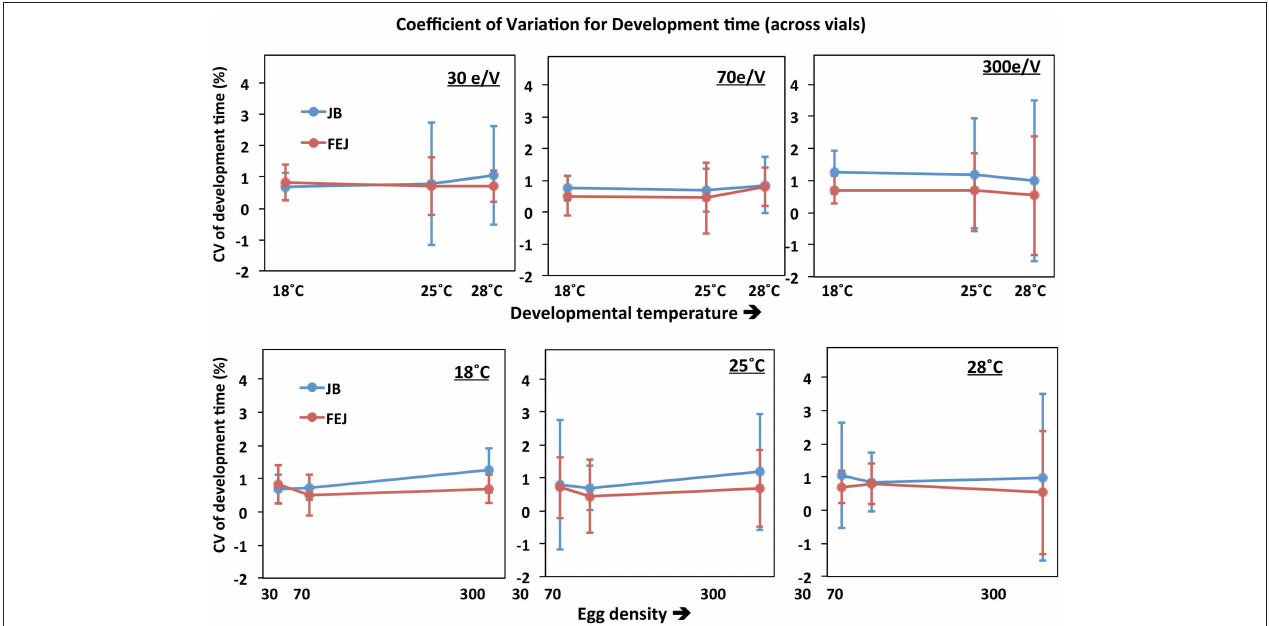
FIGURE 2 | Coefficient of variation (CV) of mean pre-adult development time of FEJ and JB populations across vials. The upper panel shows CV of the trait plotted across temperature for each treatment density (e/V = eggs per vial). The lower panel shows CV of the trait plotted across egg density for each treatment temperature. The error bars show 95% confidence intervals calculated from the variation among replicate populations in each combination of selection regime, temperature, and density.